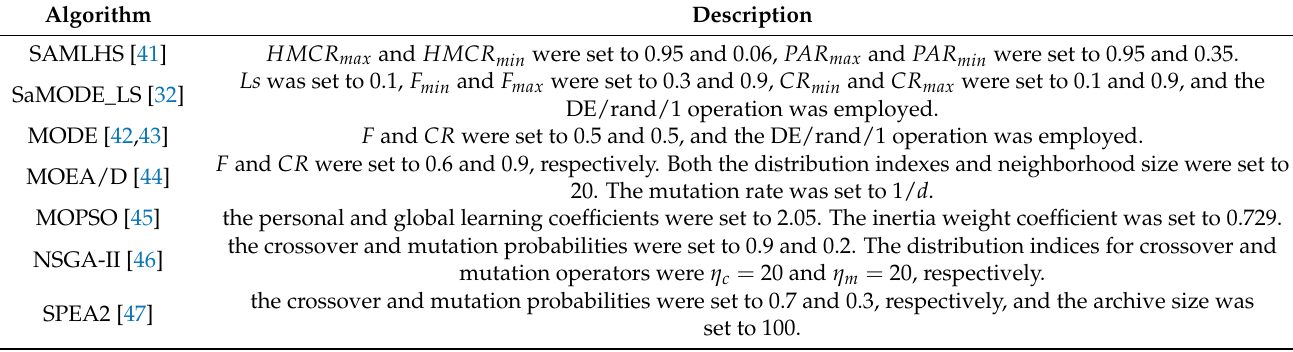
Table 3. Algorithm parameters.